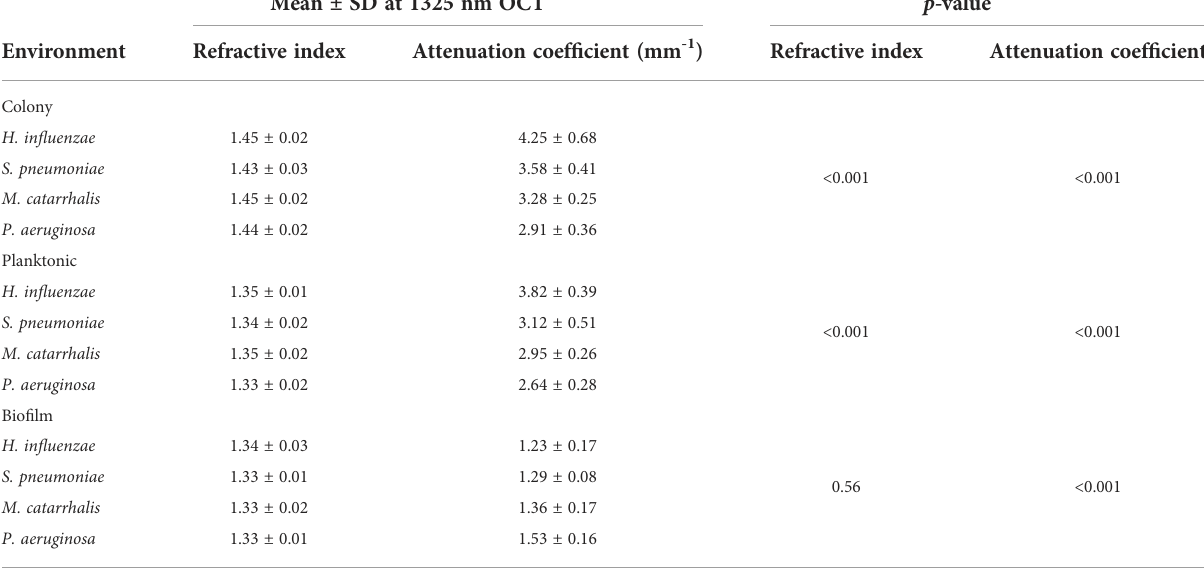
TABLE 3 Overall mean (n = 32 for each independent measurement) and statistical comparison of RI and AC for the different bacterial species in all three growth forms using the one-way ANOVA